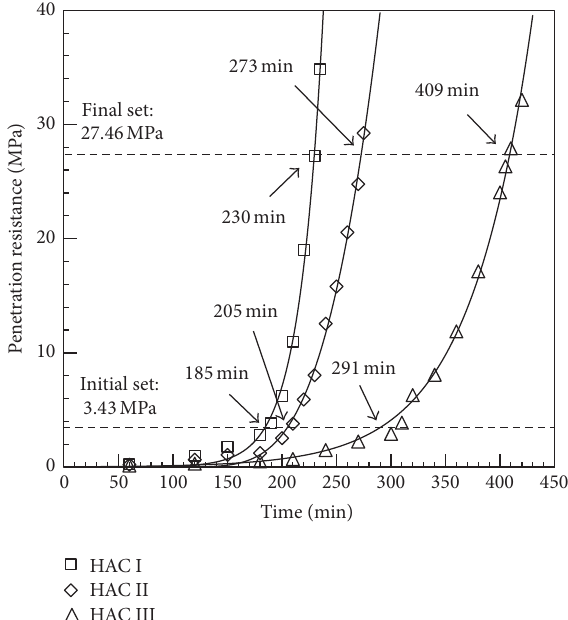
Figure 1: Penetration resistance of fresh concrete with time to determine the setting time for different HAC